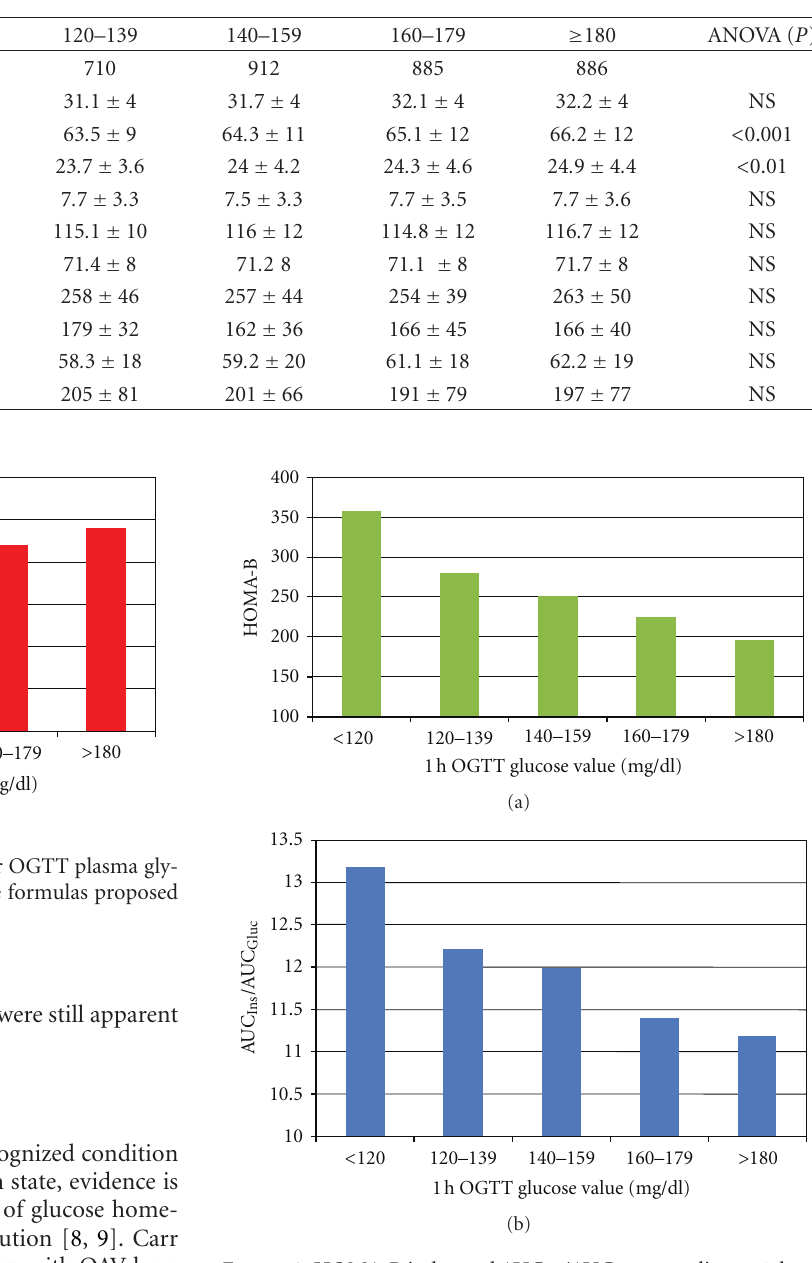
Figure 3: HOMA-B index and AUC ins /AUC gluc according to 1-hour OGTT plasma glycaemia. HOMA-B index is estimated using the formulas proposed by Matthews et al.